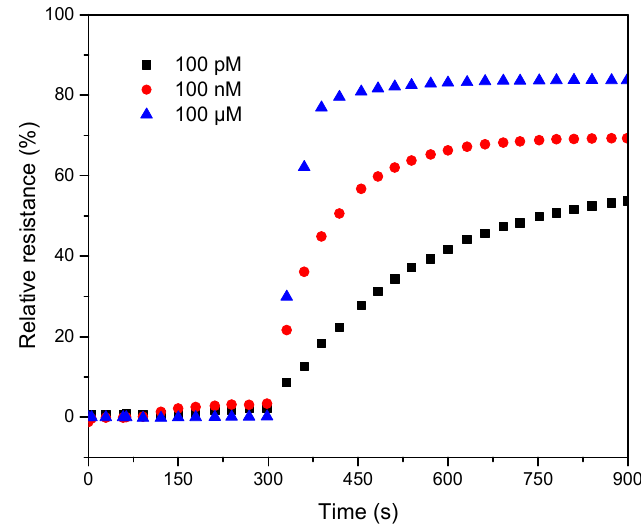
Figure 7. The effect of incubation time on the performance of the biosensor with the three Ag(I) concentrations (100 pM, 100 nM, 100 µ M) at V DS = 0.1 V and V G = 0 concentrations (100 pM, 100 nM, 100 μM) at V DS = 0.1 V and V G = 0 V.